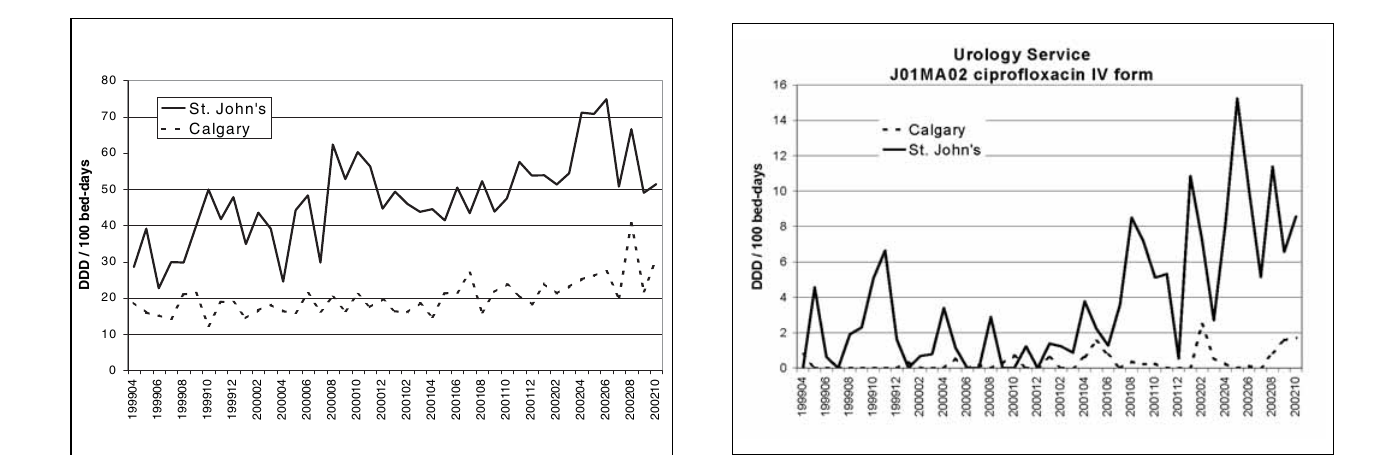
Figure 9) Comparison of consumption of the intravenous (IV) form of ciprofloxacin (J01MA02) in the Urology Service of the Healthcare Corporation of St John’s with the Urology Service of the Calgary Health Region from April 1999 to October 2002 in monthly data points. DDD Defined Daily Dose